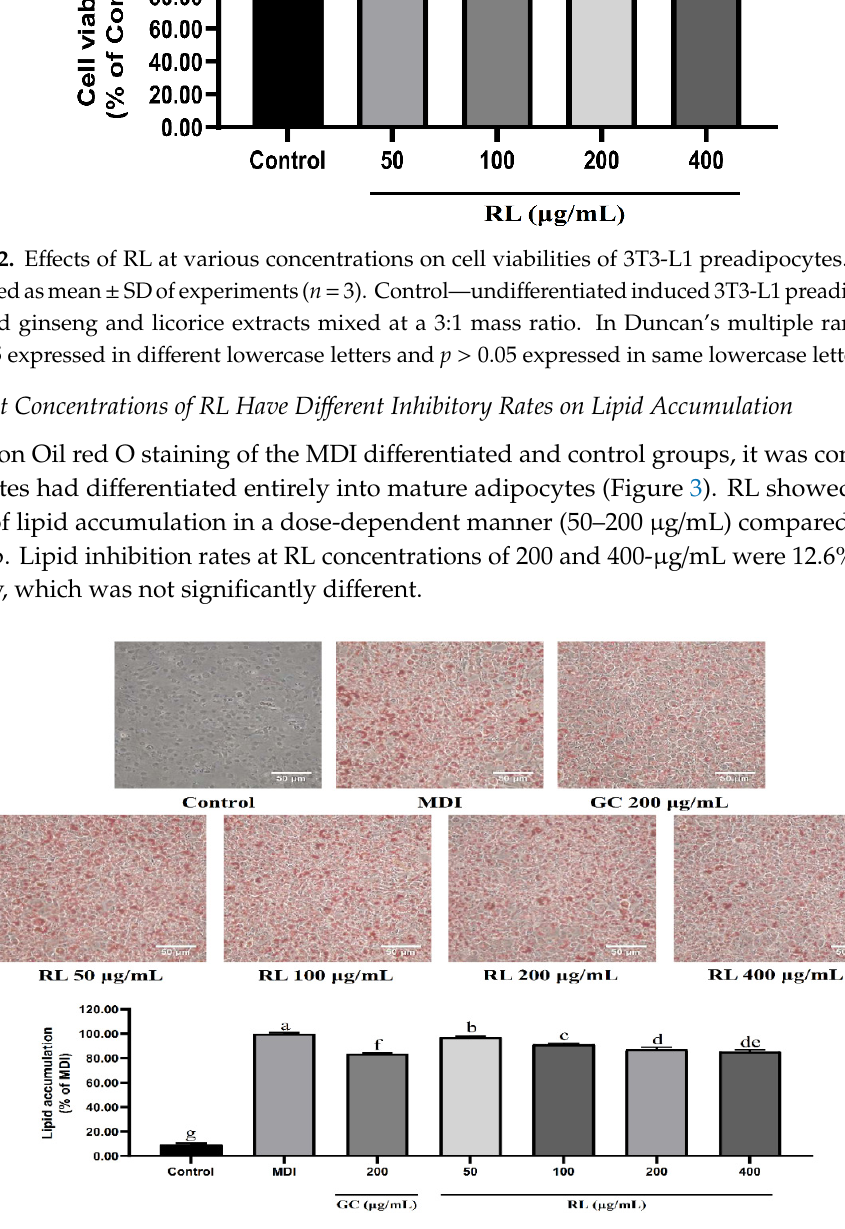
Figure 3. Inhibitory effects of RL at various concentrations on lipid accumulation in adipogenesis of 3T3-L1 cells. Control—undifferentiated induced 3T3-L1 preadipocytes; MDI—differentiated 3T3-L1 adipocytes induced by 0.5-mM IBMX, 1- μ M Dex and 10- μ g/mL insulin; GC— Garcinia cambogia water extract; RL—red ginseng and licorice extracts mixed at a 3:1 mass ratio. Values presented as mean ± SD of experiments ( n = 3). ( A ) Post-confluent 3T3-L1 preadipocytes were treated with each extract to accumulate lipids after 8 days of differentiation; ( B ) oil red O-staining on Day 8. In Duncan’s multiple range test, p < 0.05 expressed in different lowercase letters and p > 0.05 expressed in same lowercase letters.